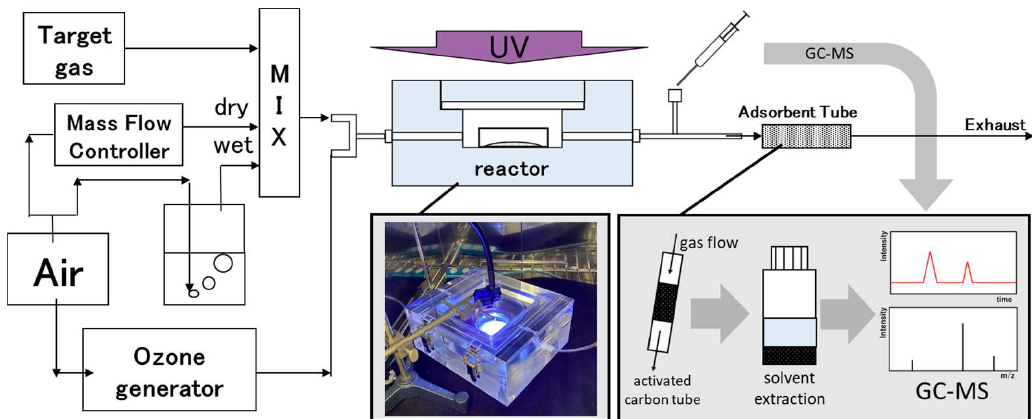
Figure 10. Photographs and schematic of evaluation equipment.